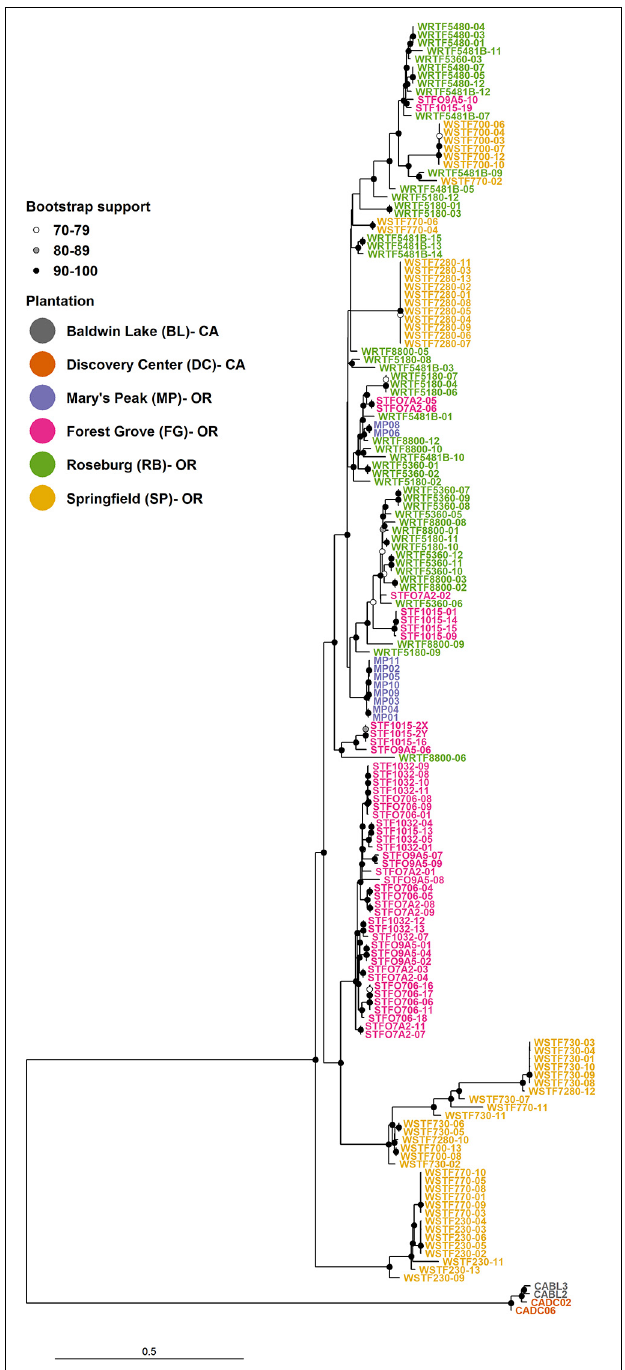
FIGURE 2 | Maximum-likelihood (ML) phylogenetic reconstruction with 155 Leptographium wageneri var. pseudotsugae haplotypes and 4 Leptographium wageneri var. wageneri haplotypes. Data consisted of 120,613 binary SNPs. Bootstrap support values were calculated from 1,000 replicate trees.